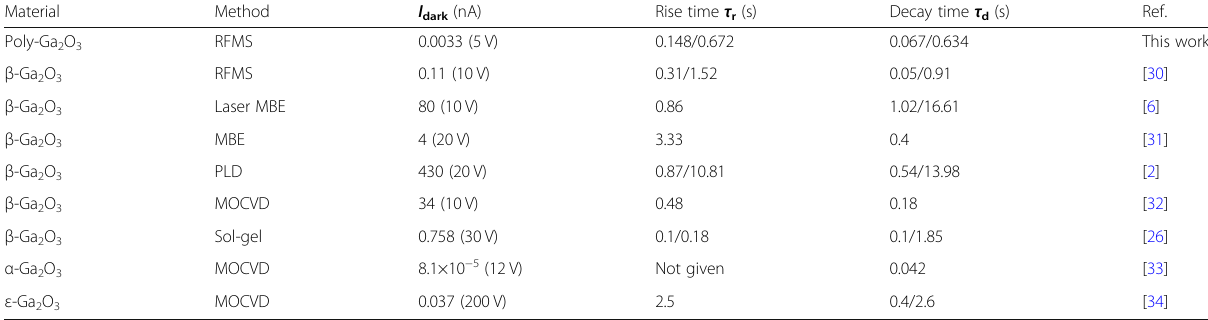
Table 4 The comparison of the I dark , rise time ( τ r ) and decay time ( τ d ) of solar-blind photodetectors based on β -, α -, and ε -Ga 2 O 3 thin films synthesized by different techniques